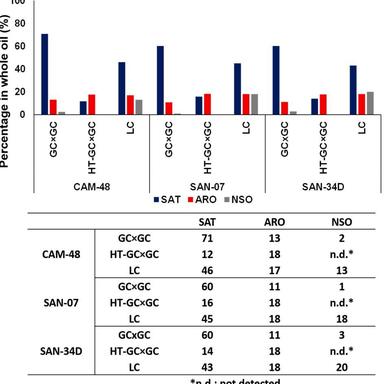
SAT, ARO and NSO fractions obtained by (a) LC, (b) GC × GC-FID and (c) HT-GC × GC-FID for three crude oil.